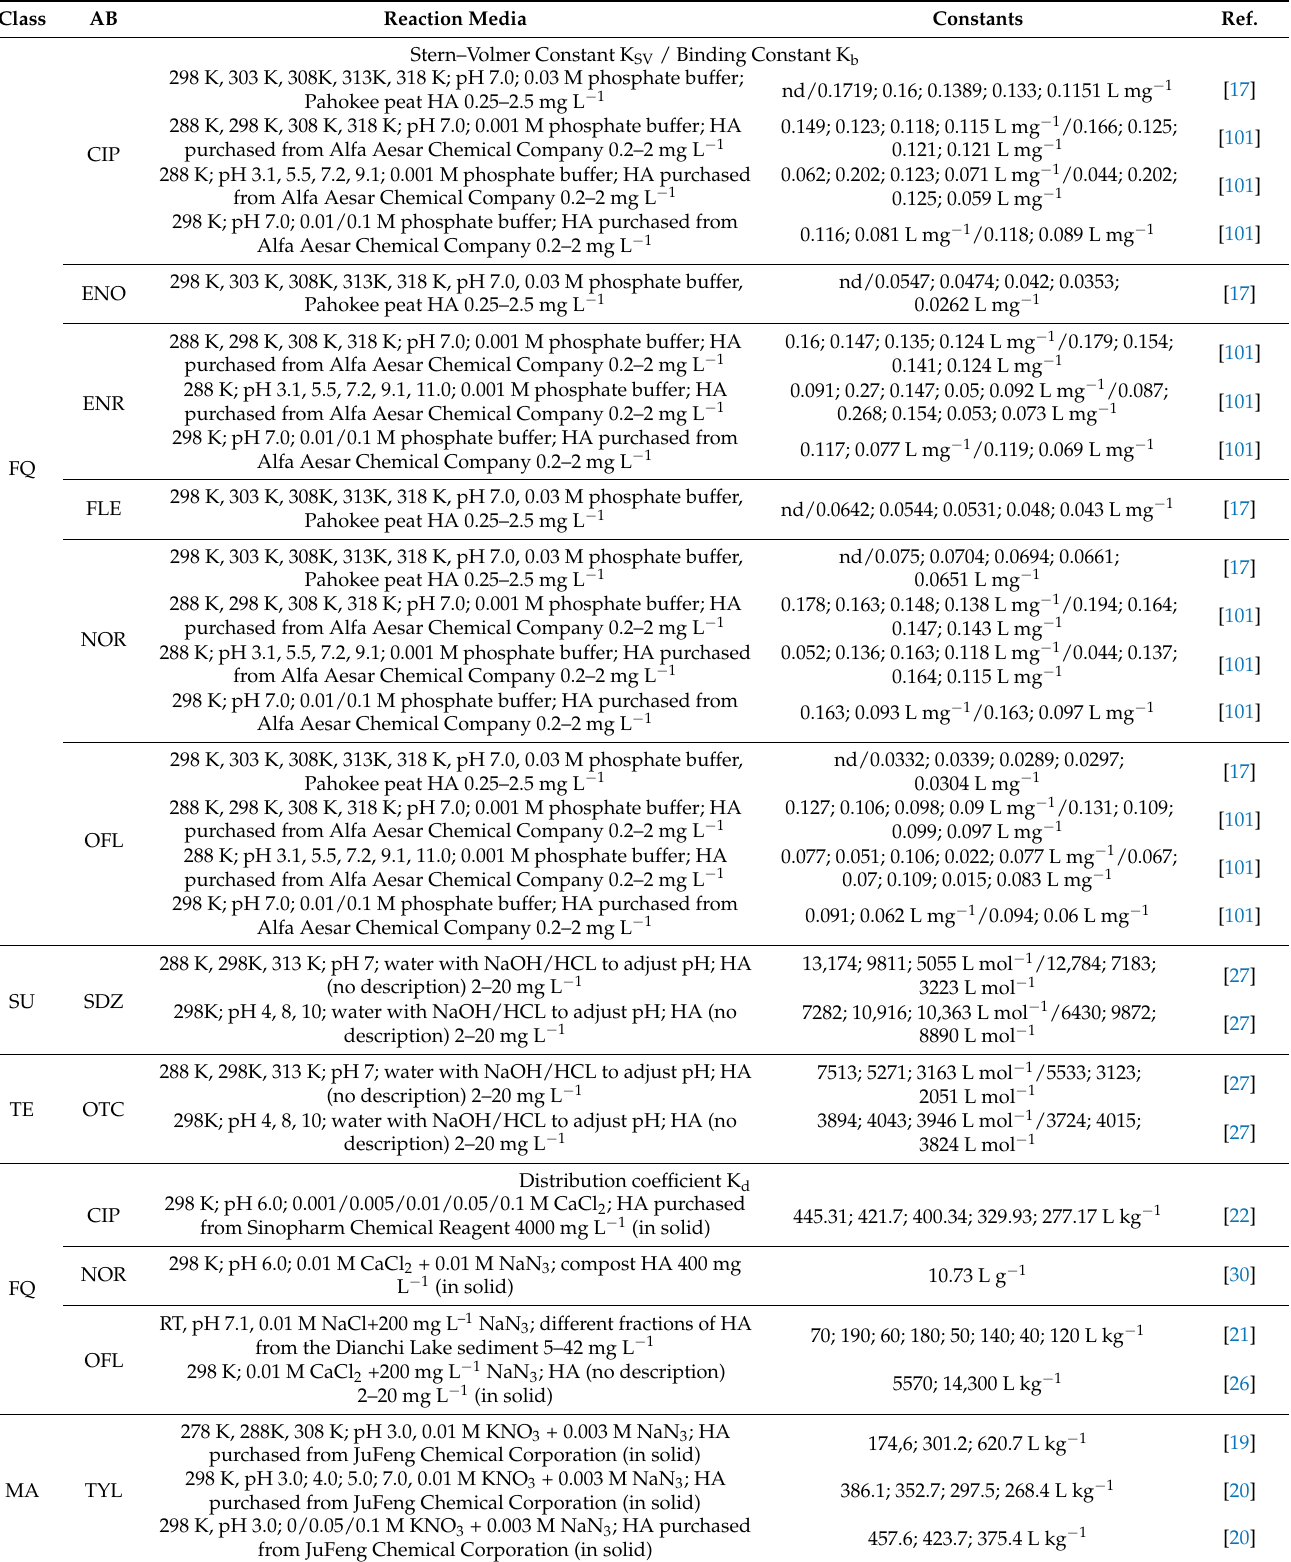
Table 3. Binding constants of HS to the selected antibiotics of different